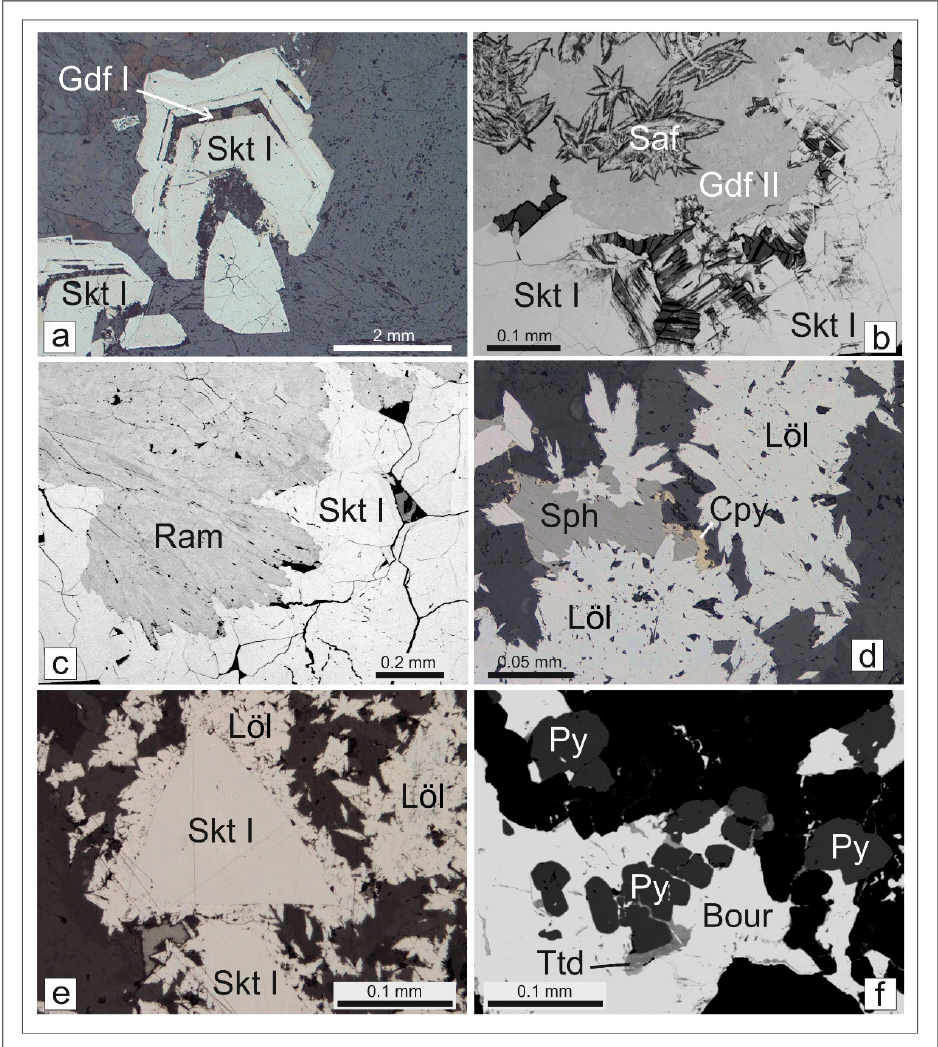
Figure 10. Microstructural features of the Co–Ni–Fe arsenides and sulfides mineralization. ( a ): coarse-grained skutterudite showing well developed growth zoning. Gersdorffite I occurs along some growth zones; ( b ): skutterudite I is partially replaced by gersdorffite II which is, in turn, overgrown by star-shaped “safflorite twins”; ( c ): skutterudite I overgrown by rammelsbergite; ( d ) late stage löllingite associated with sphalerite and chalcopyrite; ( e ) skutterudite I embedded by löllingite; ( f ) final stage bournonite embedding tetrahedrite and pyrite. (a, d, e, f: plane polarized reflected light, b, c: electron microscopy backscattered images). Abbreviations: Ccp = chalcopyrite, Gdf = gersdorffite, Löl = löllingite, Py = pyrite, Ram = rammelsbergite, Saf = safflorite, Skt I = skutterudite, Sph = sphalerite, Ttd = tetrahedrite. The Fe carbonate-rich vein filling displays distinct composition in the di ff erent stages (Table S2). Siderite I is a siderite–magnesite s.s., with very minor rhodochrosite and calcite